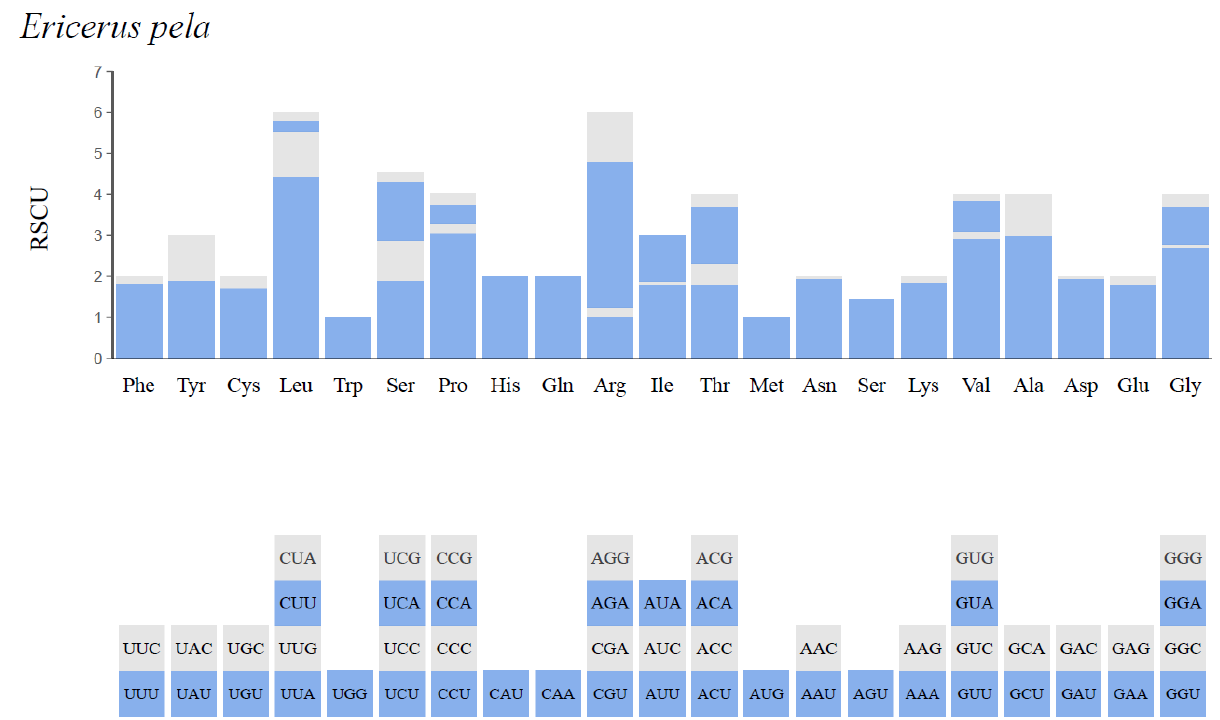
Figure 3. Relative synonymous codon usage (RSCU) of E. pela .